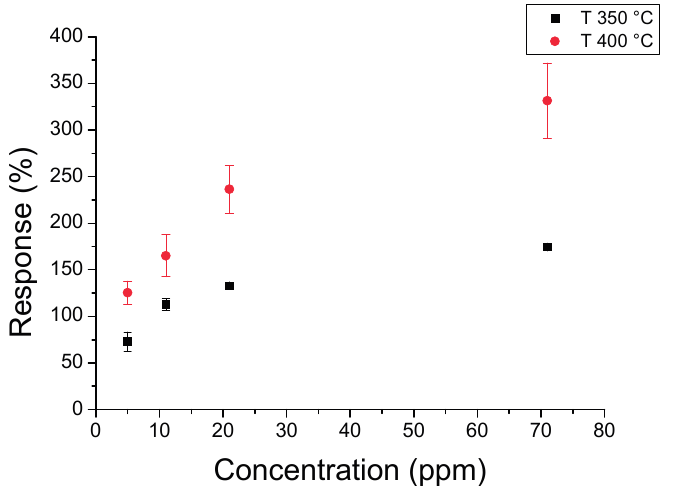
Figure 8. Response of a nanofiber sensor with 120 s deposition time and 450 °C annealing temperature to acetone at 350 °C and 400 °C.